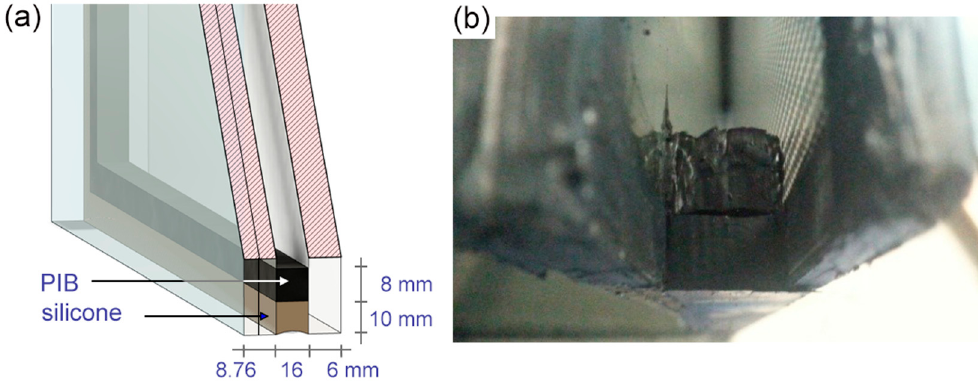
Figure 4. Overview of warm edge system: ( a ) schematic of the model ( b ) photo of the actual cavity space with primary and secondary seals.